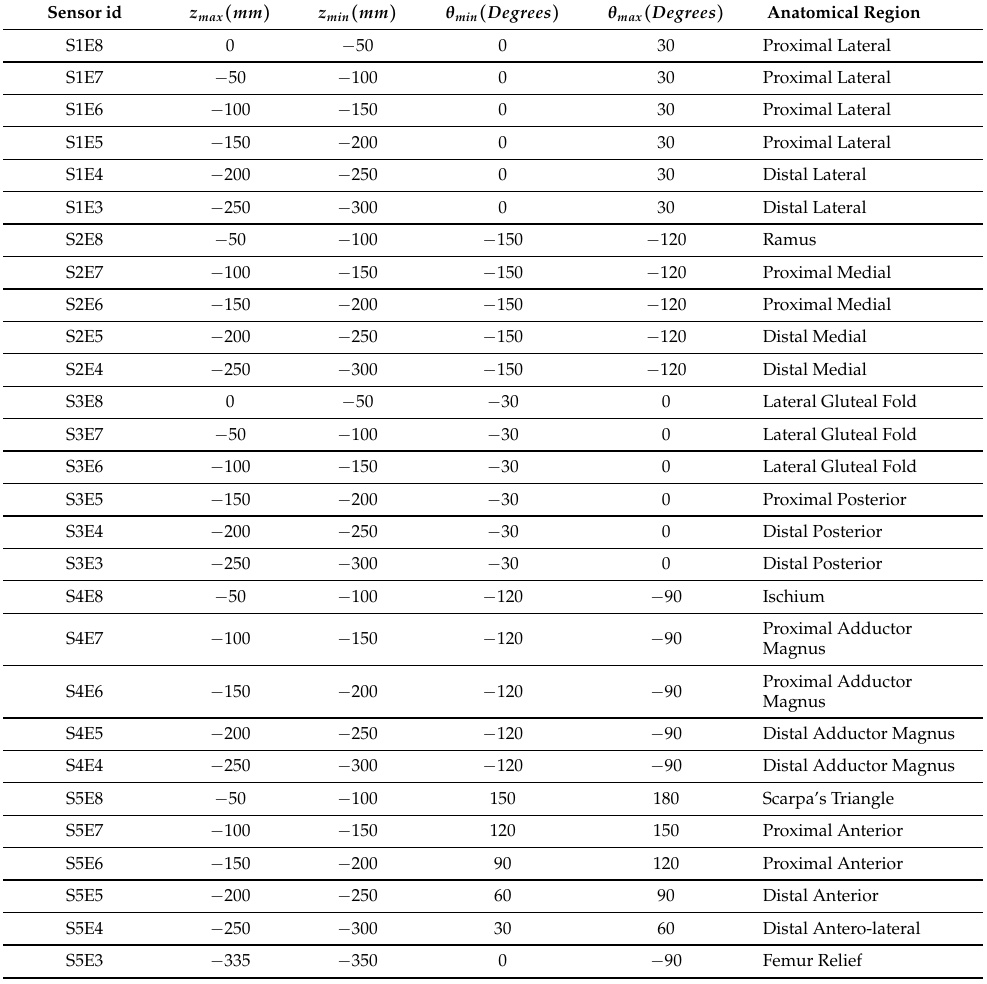
Table A2. Mapping of sensors to